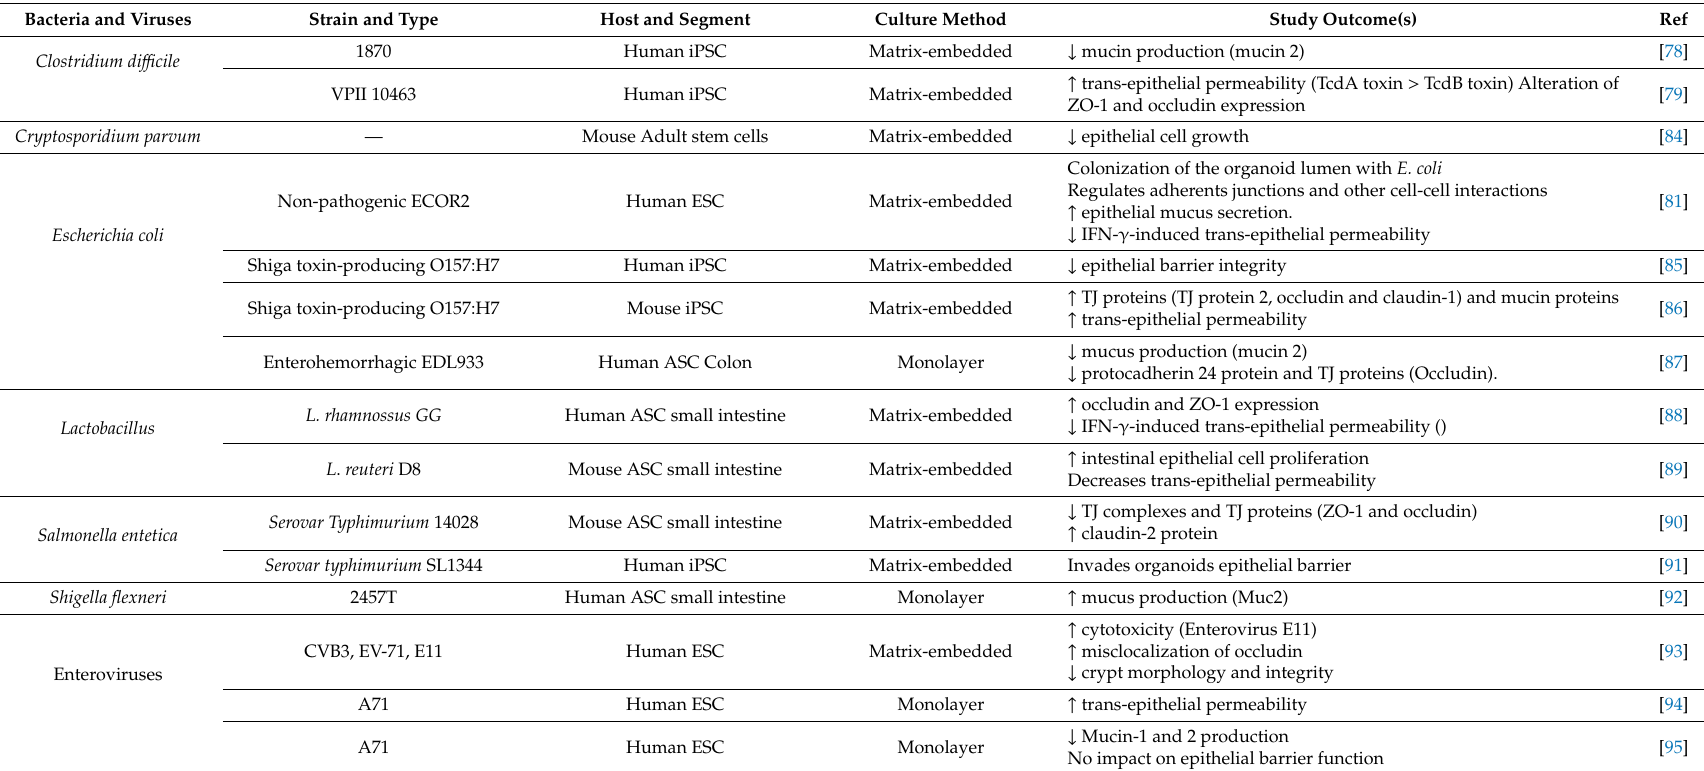
Table 1. Studies reporting gut microbiota-epithelial cell interactions using intestinal epithelial